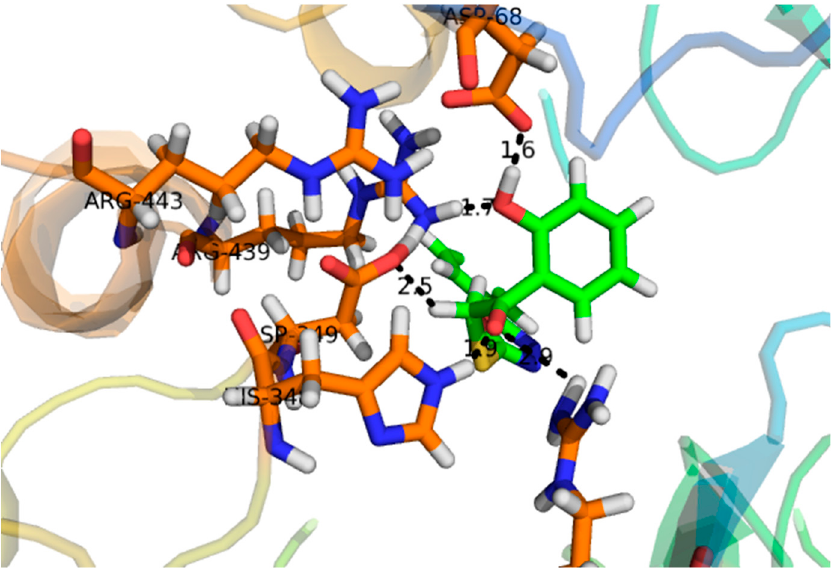
Figure 3. Represents the 3D structures of Compound 1 showing binding potential. Red color in the image shows position of oxygen, green benzene ring, white hydrogen atom, brown color indicates amino acid sequence and blue color indicate nitrogen or amino group.